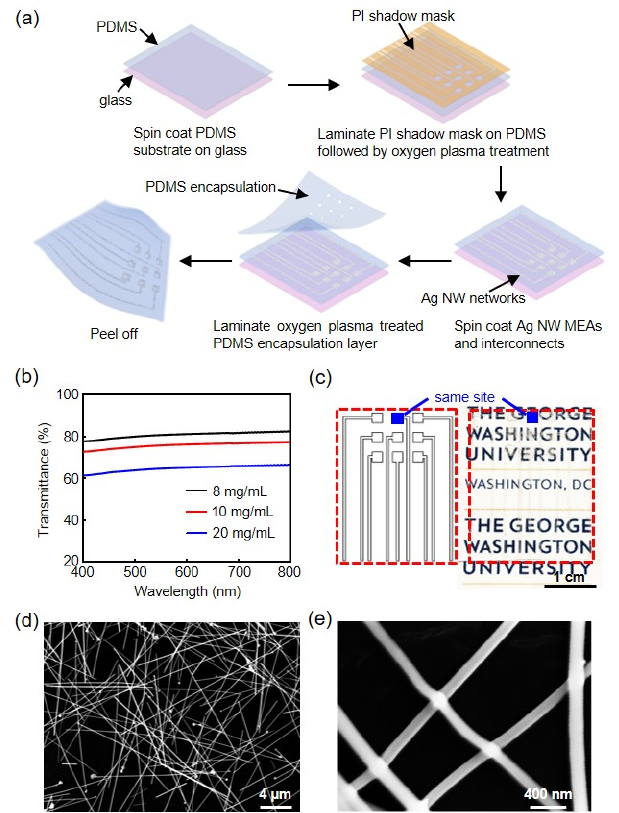
Figure 1. ( a ) Schematic illustration of the fabrication steps for the stretchable and transparent Ag NW MEA and interconnects. ( b ) Transmittance spectra of Ag NW networks. ( c ) ( Left ) Schematic design of a 3 × 3 Ag NW MEA and interconnects. The inner blue box highlights a microelectrode in the MEA. ( Right ) Photograph of the 3 × 3 Ag NW MEA and interconnects to show the high optical transparency. The device areas are highlighted by the red dashed box. ( d ) SEM image of the Ag NW structures at 10 mg/mL. ( e ) Magnified SEM image of the Ag NW structures.